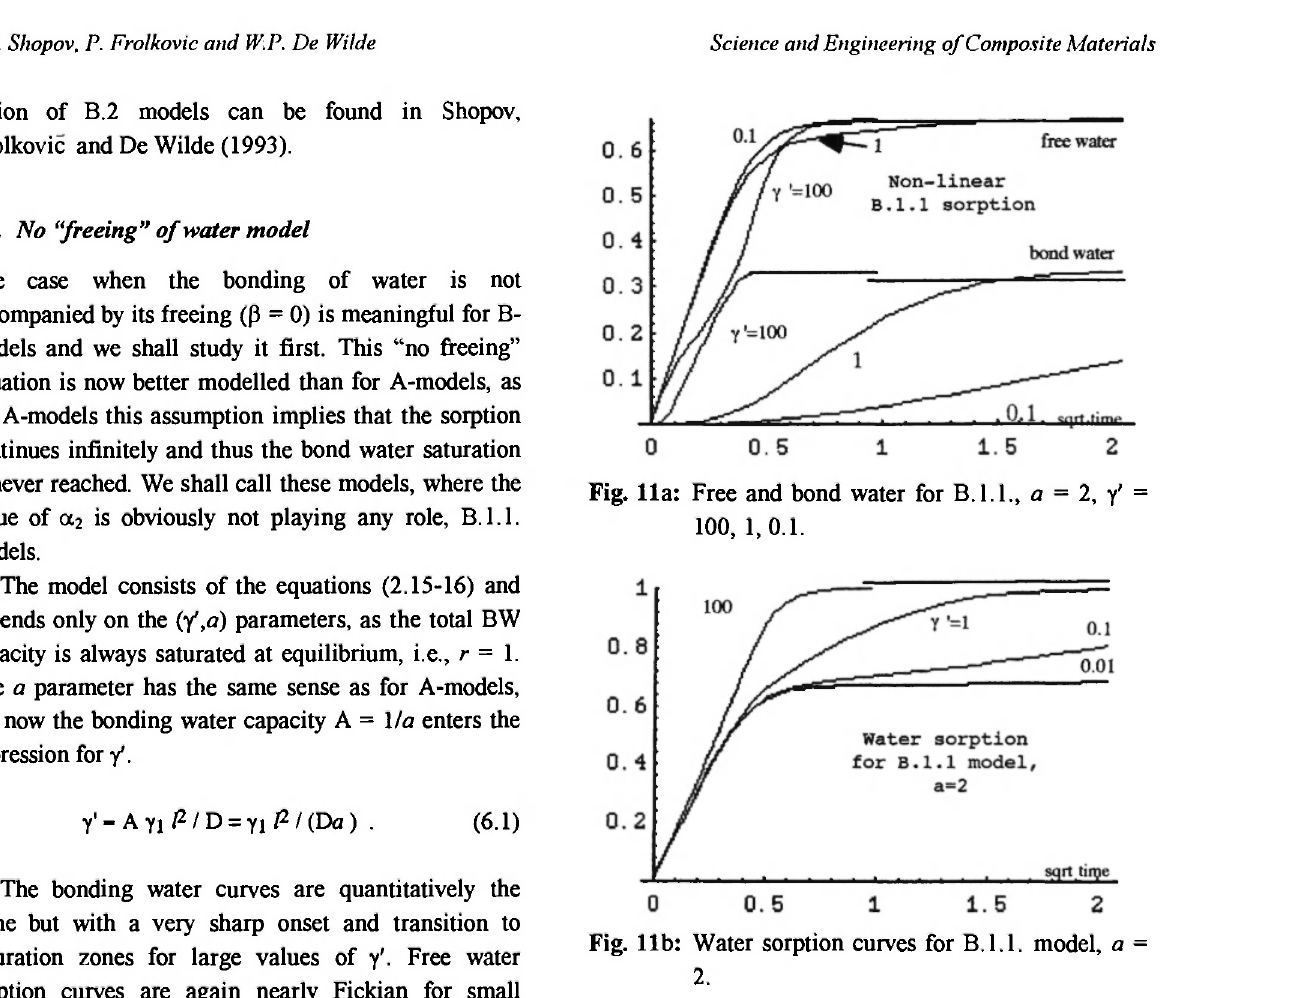
Fig. lib: Water sorption curves for B.l.l. model, a =